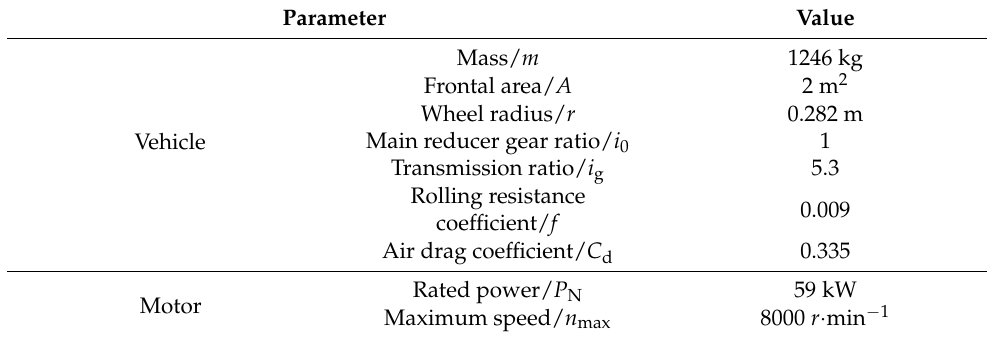
Table 2. Vehicle parameter.